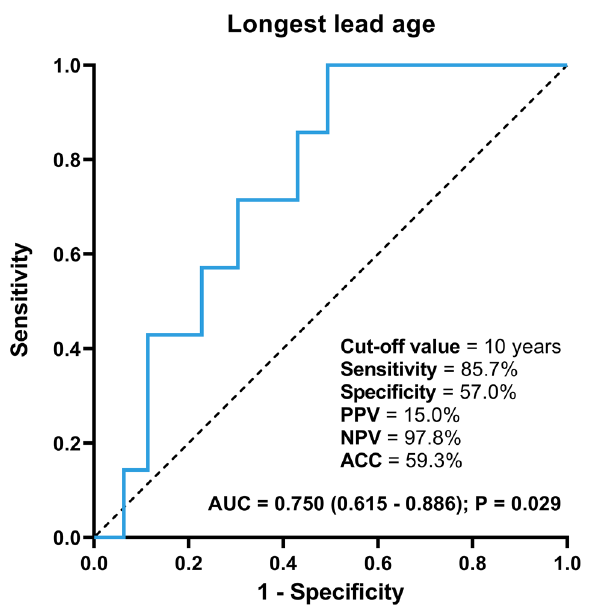
Figure 2. Receiver operating characteristic curve for the longest lead age in predicting clinically significant pericardial effusion. ACC accuracy, AUC area under the curve, NPV negative predictive value, PPV positive predictive value